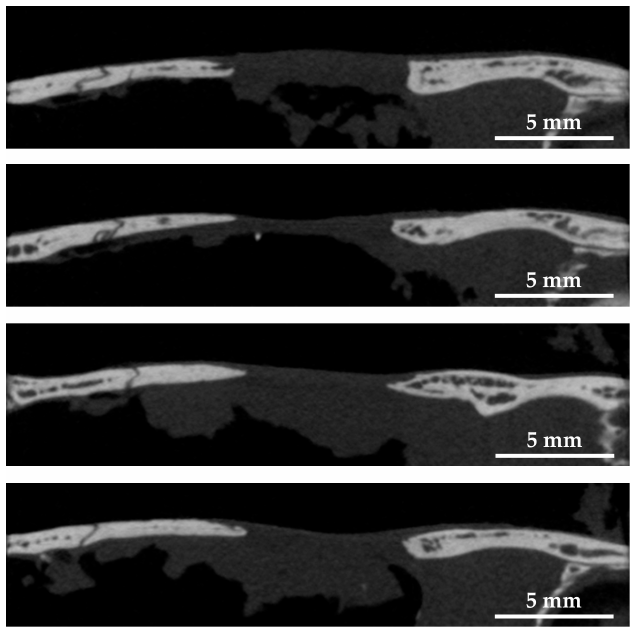
Figure 9. Micro-computed tomography (micro-CT) images of sagittal planes of four rat cranial bone defects filled with cHLA/cAG/nHAp/BMP constructs at 8 weeks after the operation. Note: The bone edge had a steeple configuration due to bone extension.